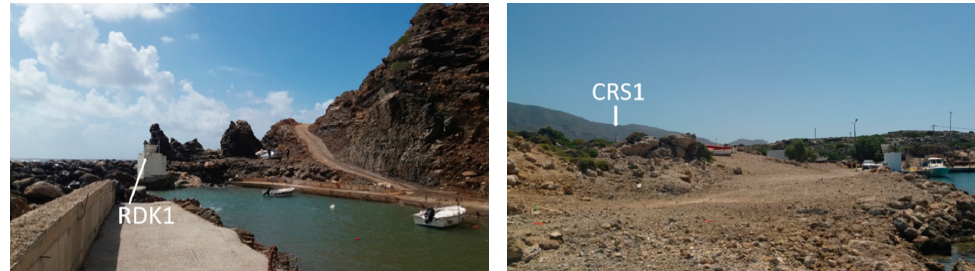
Figure 7. The OLCI image pixel corresponding to the coastal GNSS stations of RDK1 ( left ) and CRS1 ( right ) is flagged as “WATER” and “LAND” respectively. This introduces large errors in IWV determination at the RDK1 station thus they were excluded from further analysis when the “single point” approach was followed.